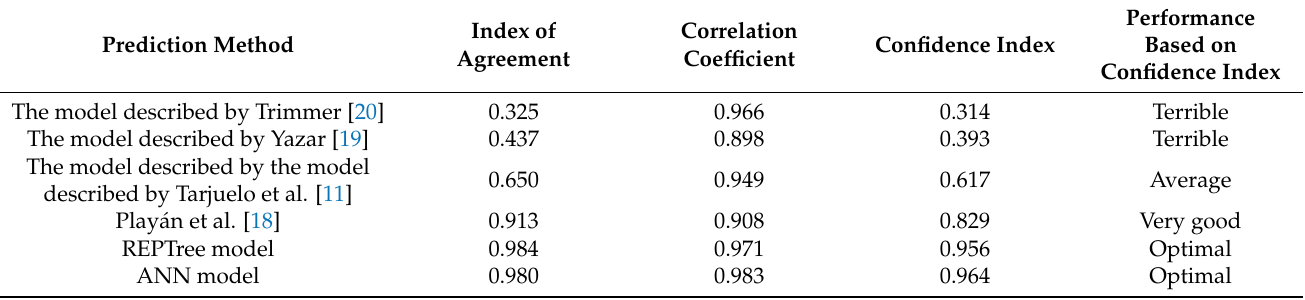
Table 6. Results of the index of agreement (d), correlation coefficient (r), and confidence index (c) tests for the different prediction methods in relation to observed WDEL using the testing data